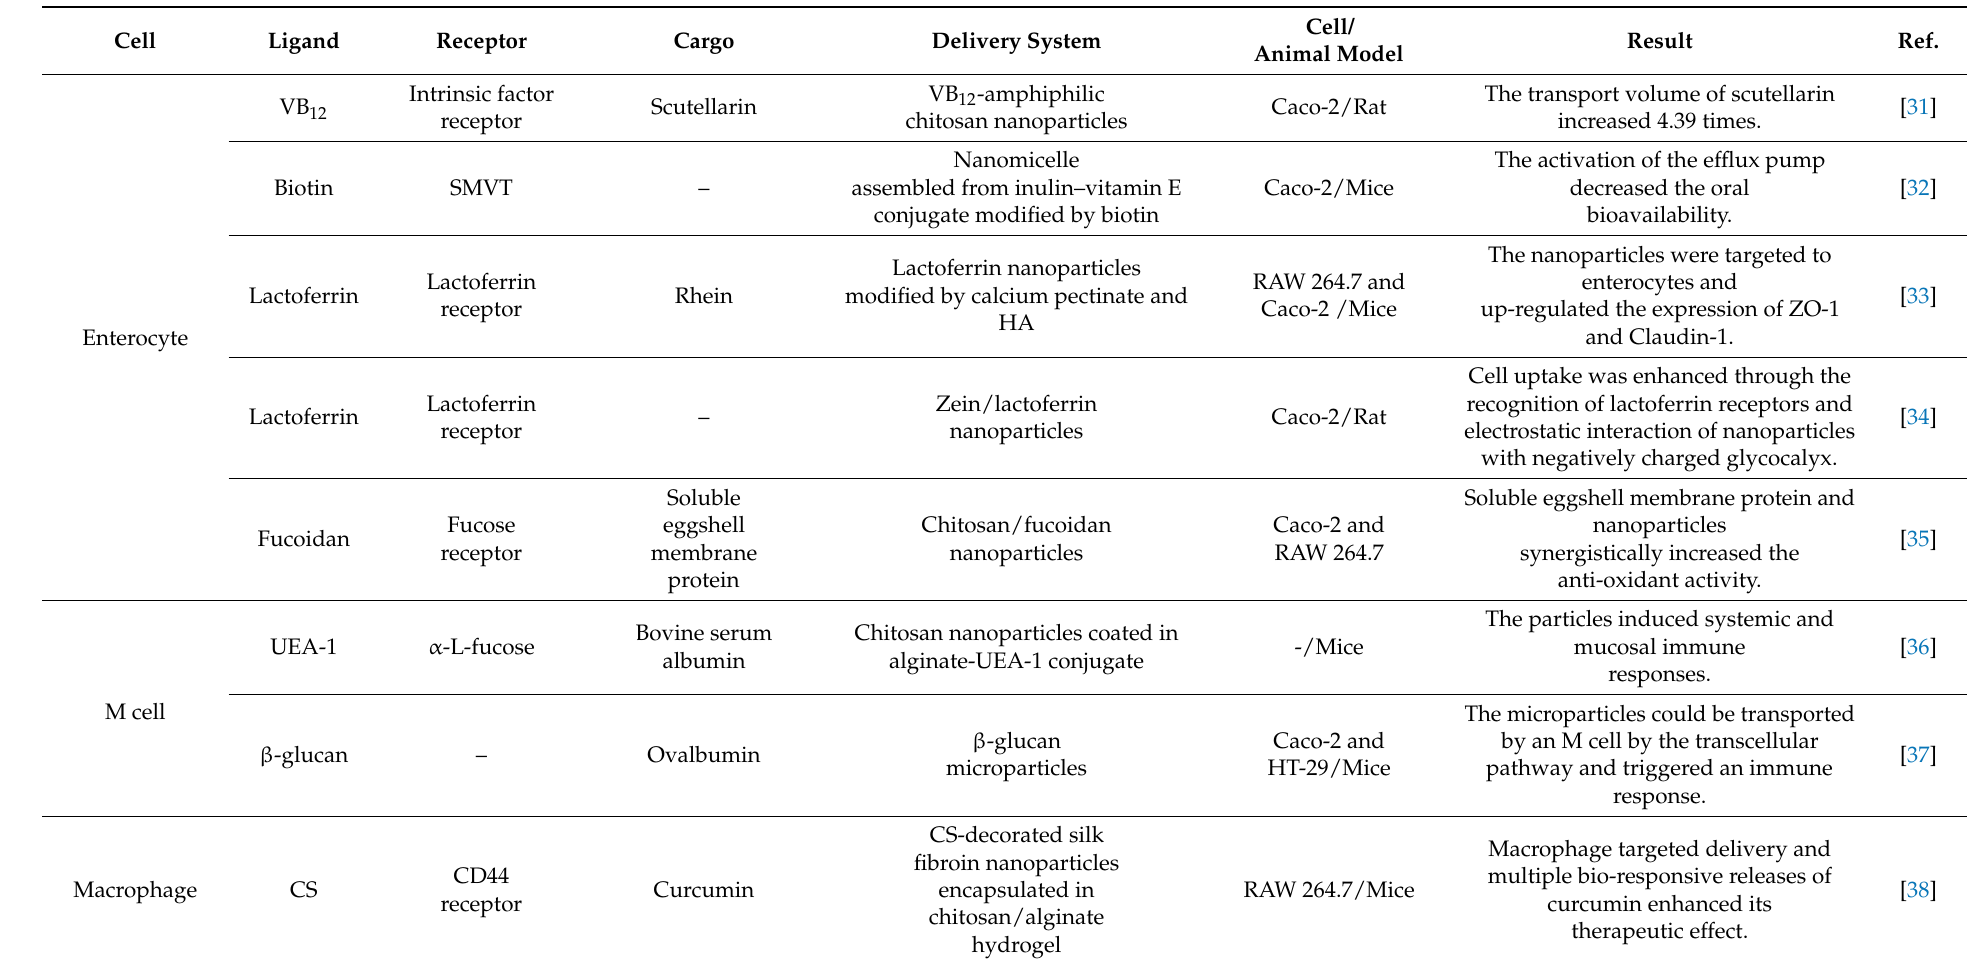
Table 1. The structure and function of cell-targeted delivery systems constructed of edible